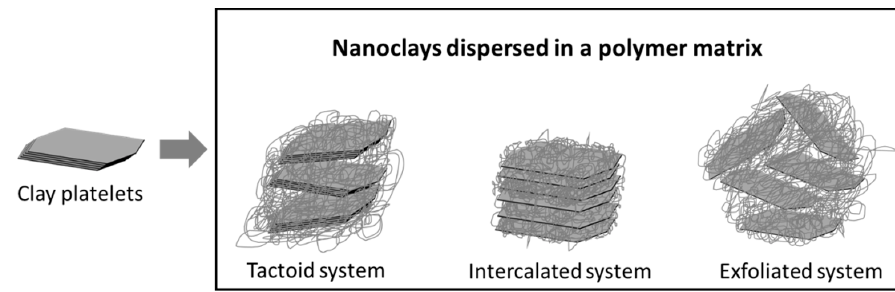
Figure 5. Tactoid, intercalated, and exfoliated polymer–clay systems. Adapted from [52]. Gorrasi et al. found that while tactoid and intercalated montmorillonite/ polycaprolac-